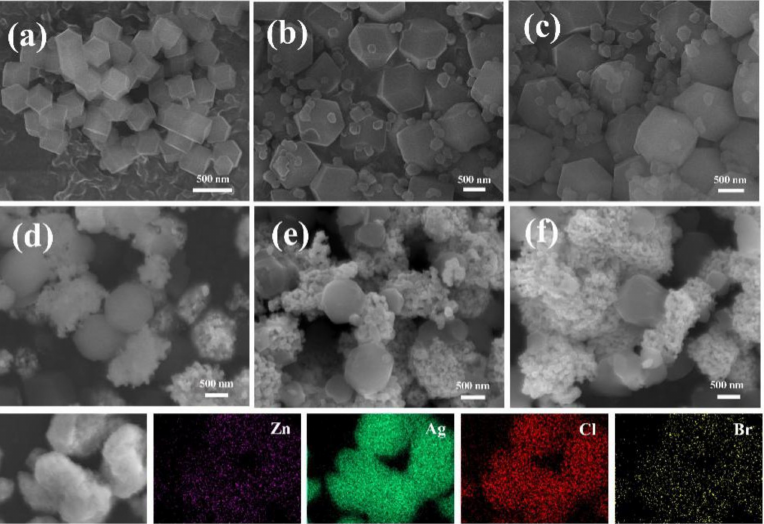
Figure 3. SEM images of ( a ) ZIF-8, ( b , c ) AC@Z, and ( d – f ) AB/AC@ZX (X = 1, 3, and 5).